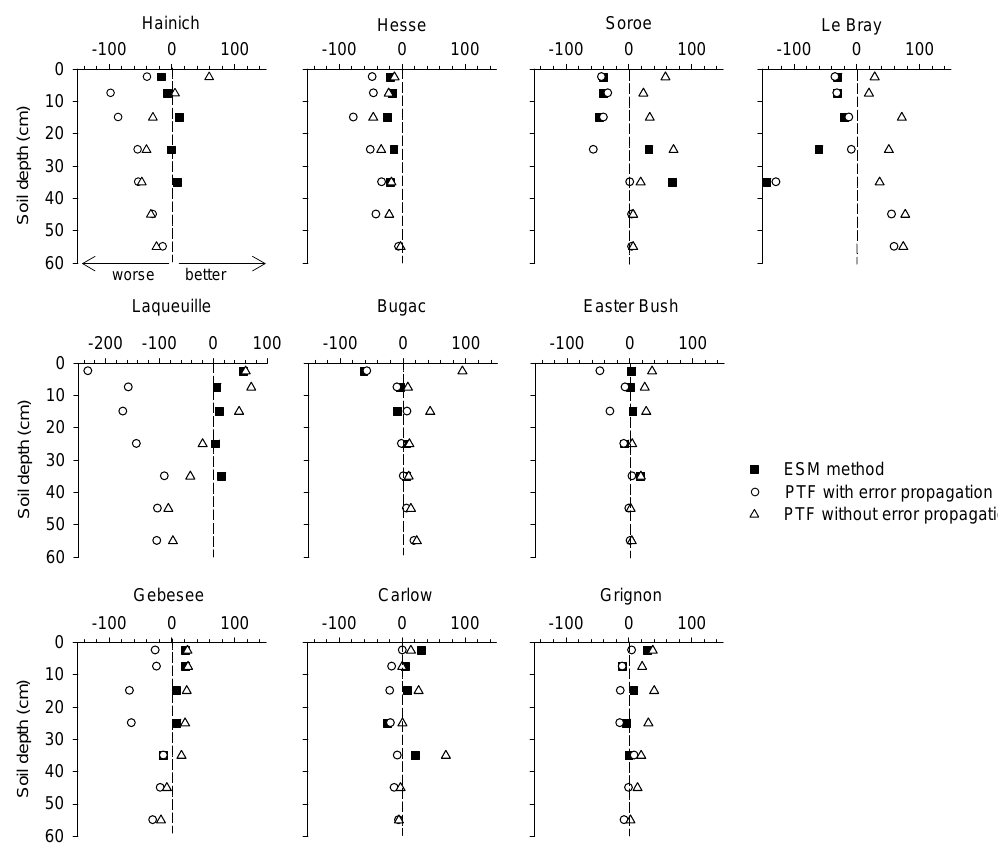
Fig. 7. Difference between minimum detectable difference (MDD) of measured OC stocks and (1) the MDD calculated for OC stocks expressed for equivalent soil masses (ESM) of respective layers, (2) the MDD of OC stocks calculated with BD estimated using a pedotransfer function (PTF) without error propagation, and (3) the MDD of OC stocks calculated with BD estimated by a PTF with error propagation at different sites.